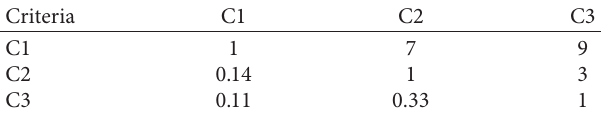
Table 3: Matrix of criteria importance.